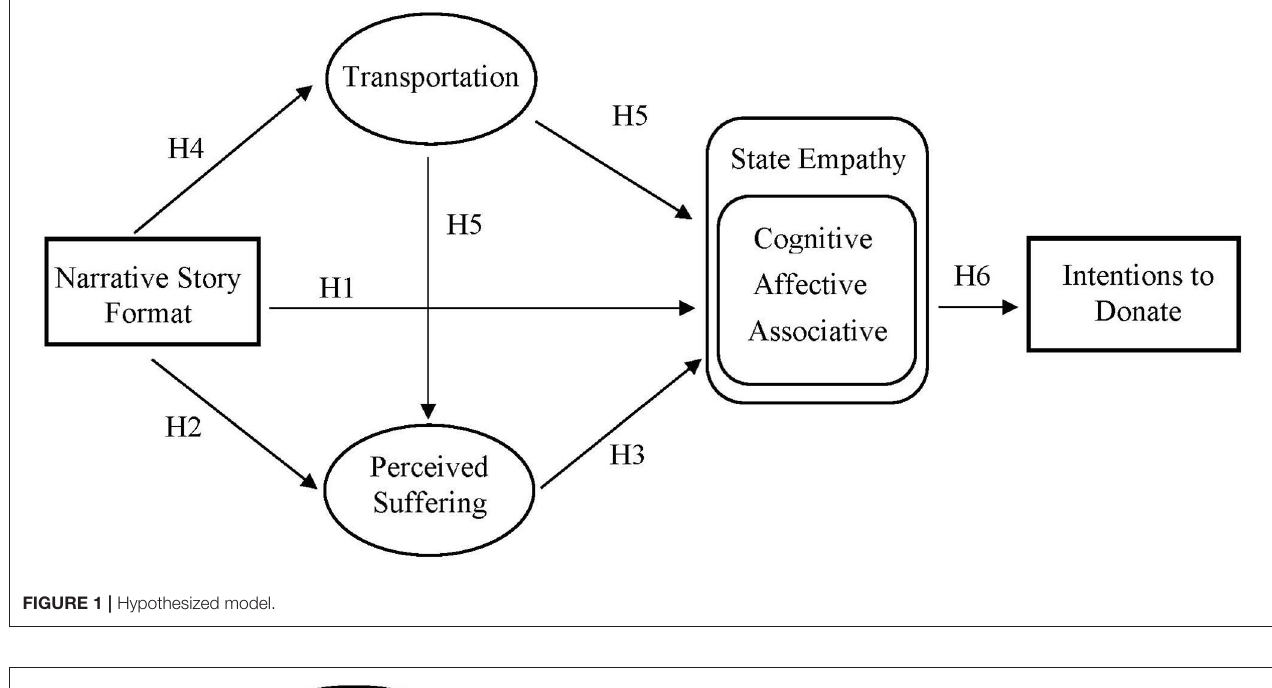
FIGURE 1 | Hypothesized model.